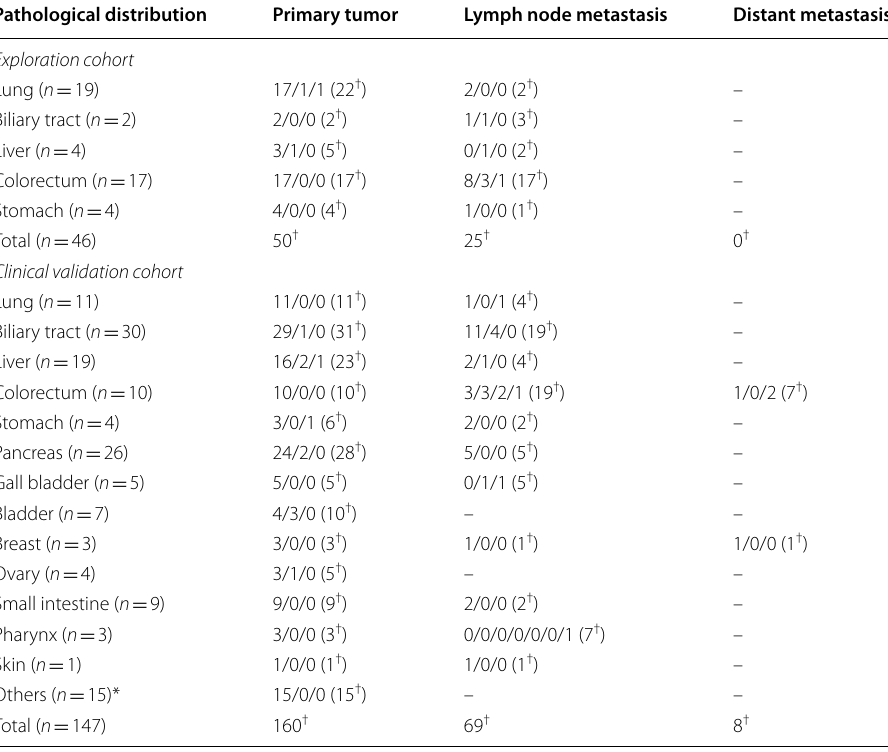
Values separated by virgules (/) indicate the number of patients with 1/2/3/4/5/6/7 lesions † Data are numbers of lesions